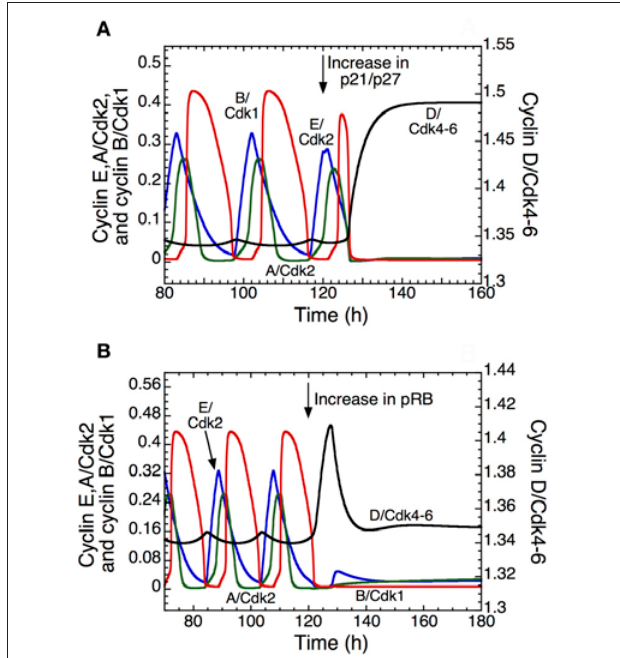
FIGURE 5 | Arresting the mammalian cell cycle in the G1 phase. The curves show the time evolution of cyclin D/Cdk4–6 (in black), cyclin E/Cdk2 (in blue), cyclin A/Cdk2 (in green), and cyclin B/Cdk1 (in red) in the detailed model for the Cdk network. In t = 120h, the transition from a sustained oscillatory regime of the Cdk network, corresponding to cell proliferation, to a stable steady state corresponding to cell cycle arrest follows the overexpression of p21–p27 when v s1p27 passes from 0.8 to 5 μ Mh − 1 (A) , or the overexpression of pRB when v spRB passes from 0.8 to 1.2 μ Mh − 1 (B) . The final, stable steady state is characterized by a high level of cyclin D/Cdk4–6 and low levels of the other cyclin/Cdk complexes, which could correspond to a cell cycle arrest in G1. Other parameter values are as in Table S2 in Gérard and Goldbeter (2009).